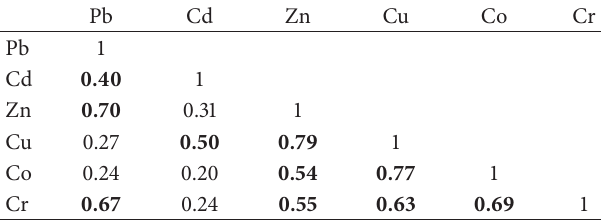
Table 3: Correlation coefficient among metals in tree bark samples from all zones (bold correlations are significant at 𝜌 < 0.05